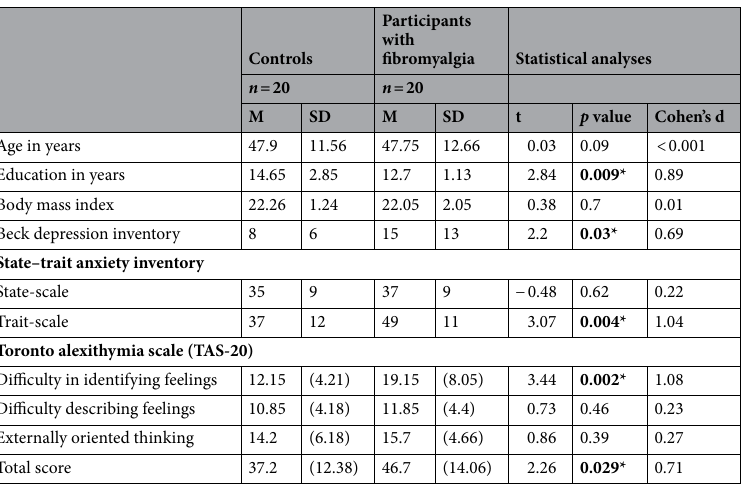
Table 1. Mean (M) and standard deviation (SD) relative to the demographical characteristics and the psychological questionnaires are reported for controls and the participants affected by fibromyalgia. Significant values ( p value < 0.05) are in bold and indicate